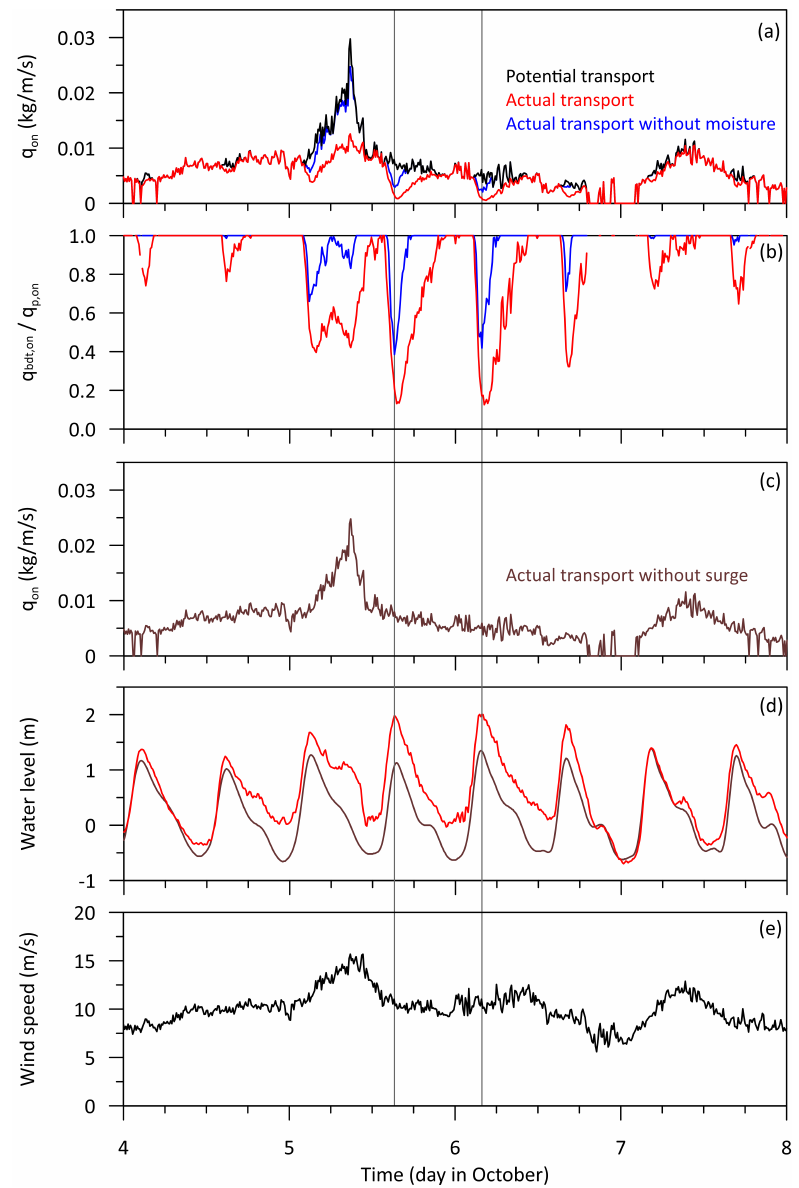
Figure 12. Results of aeolian transport modeling for a selected 4-day period in early October 2017. ( a ) shows the onshore potential transport rate q p ,on (black line) and the onshore actual transport rate at the beach-dune transition q bdt,on (red line). The blue line in ( a ) is q bdt,on in case the effect of surface moisture on q is ignored (i.e., w s = 0 at all non-submerged locations). ( b ) illustrates the ratios between q bdt,on and q p ,on with (red line) and without (blue line) surface moisture. ( c ) shows the results of another scenario (dark brown line) in which the astronomical tide is used as seaward boundary condition in the groundwater module (i.e., no storm surge and run-up; surface moisture is included). The applied astronomical boundary condition in ( c ) is the dark brown line in ( d ), with the red line in ( d ) being the seaward boundary condition applied in both model simulations shown in panel ( a ). The wind speed on the beach is given in ( e ). The two vertical lines through all panels are the two moments with the highest tides on 5 and 6